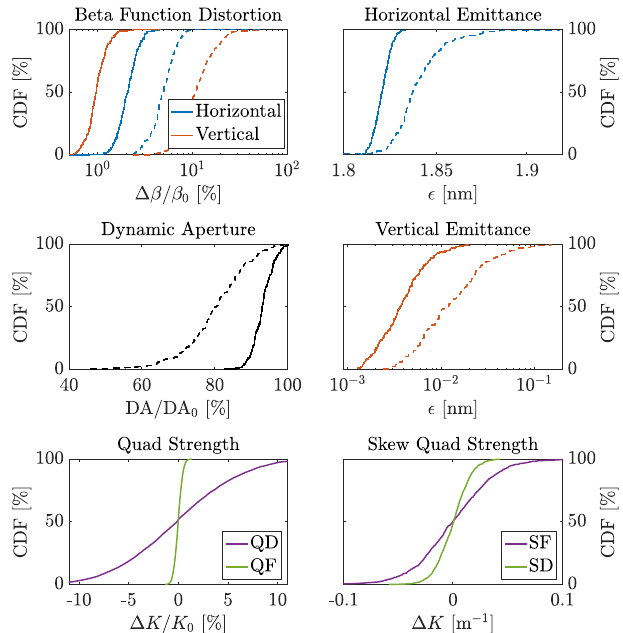
FIG. 15. Visualization of LOCO results. Shown are the cumu- lative distribution functions (CDF) of the beta beat, dynamic aperture and emittance before (dashed) and after (solid) LOCO in the upper four plots. The lower plots show the final relative quadrupole setpoint deviation from the design value (left) and the required skew quadrupole strength (right).